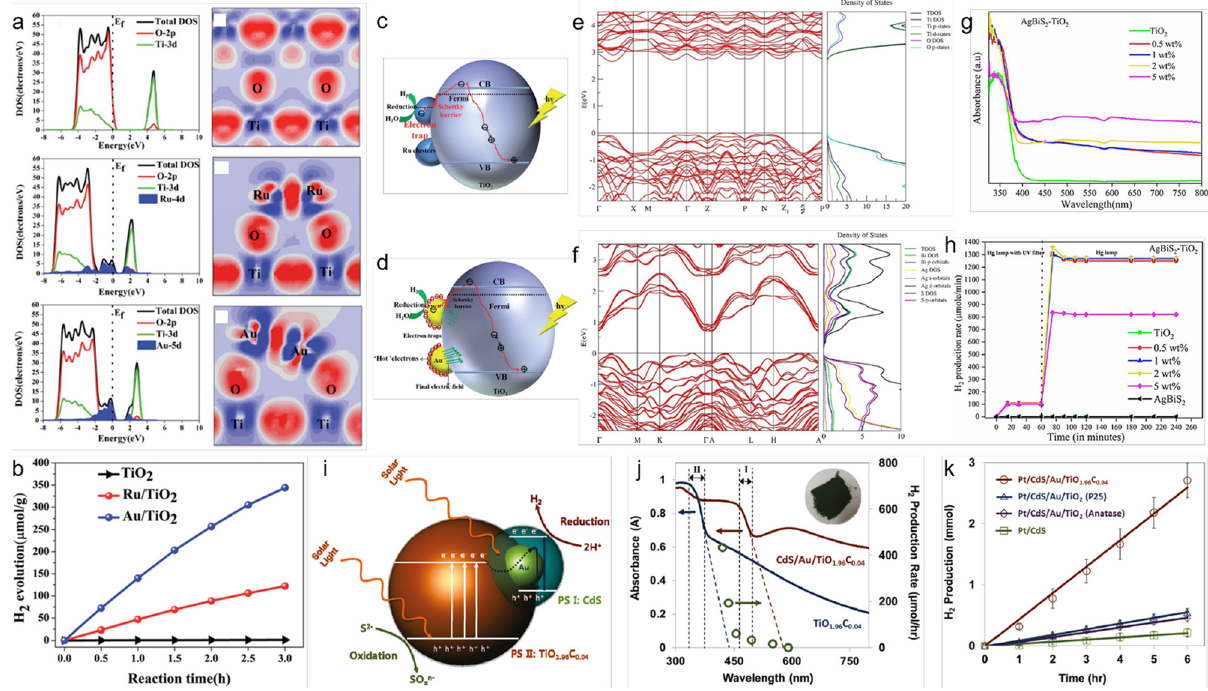
Figure 3: ( a ) Density of states and di ff erence in the charge density of the con fi guration model of anatase TiO 2 , Ru/TiO 2 , and Au/TiO 2 , respectively. ( b ) Photocatalytic H 2 evolution reactions mediated by various photocatalysts. ( c ) Schematic of the mechanism of electron - traps for photocatalytic overall water splitting. ( d ) Schematic of the mechanism of intensi fi cation of SPR, reprinted with permission from ref. [ 111 ] , Copyright ( 2020 ) Royal Society of Chemistry. Calculated electronic structure and PDOS of ( e ) TiO